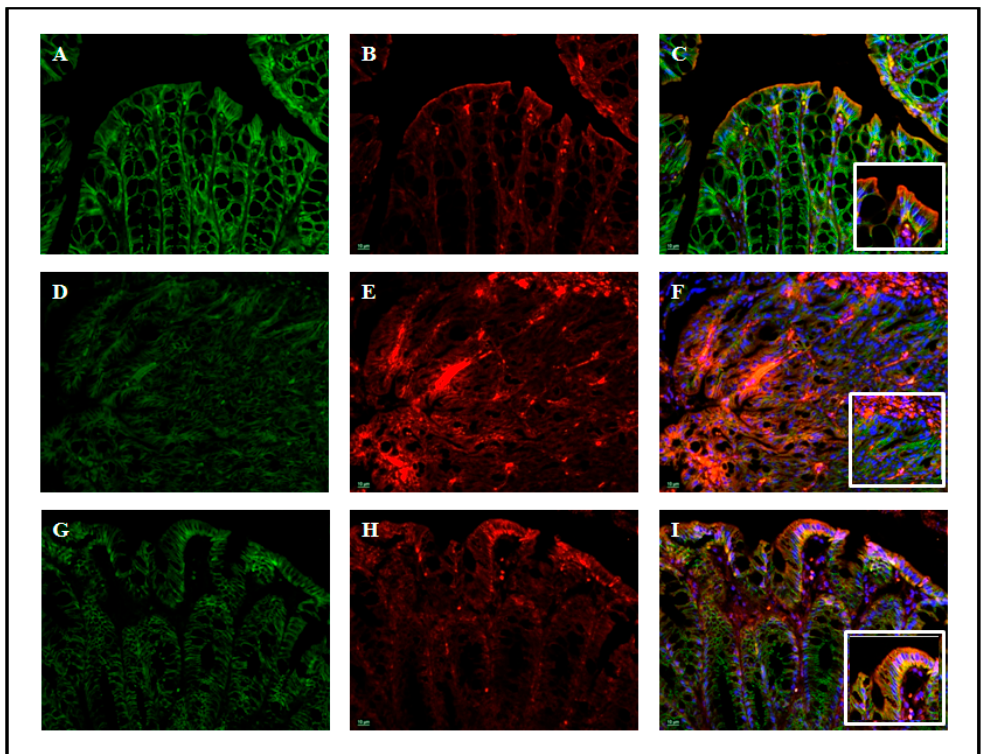
Figure 7. MBCP induces the organization of colonic AJs in DNBS-induced colitis in mice. Immunofluorescence analysis showing the expression of E-cadherin (red) and β -catenin (green) in control ( A – C ), DNBS ( D – F ) and DNBS plus MBCP ( G – I ) (100 mg/kg) mice. Original magnification 20 × . A magnified portion of the immunofluorescence was shown at higher magnification in the inset of panel ( C , F , I ). The DNBS-induced colitis in mice was treated for three consecutive days after the inflammatory insults with MBCP (100 mg/kg, by oral gavage).